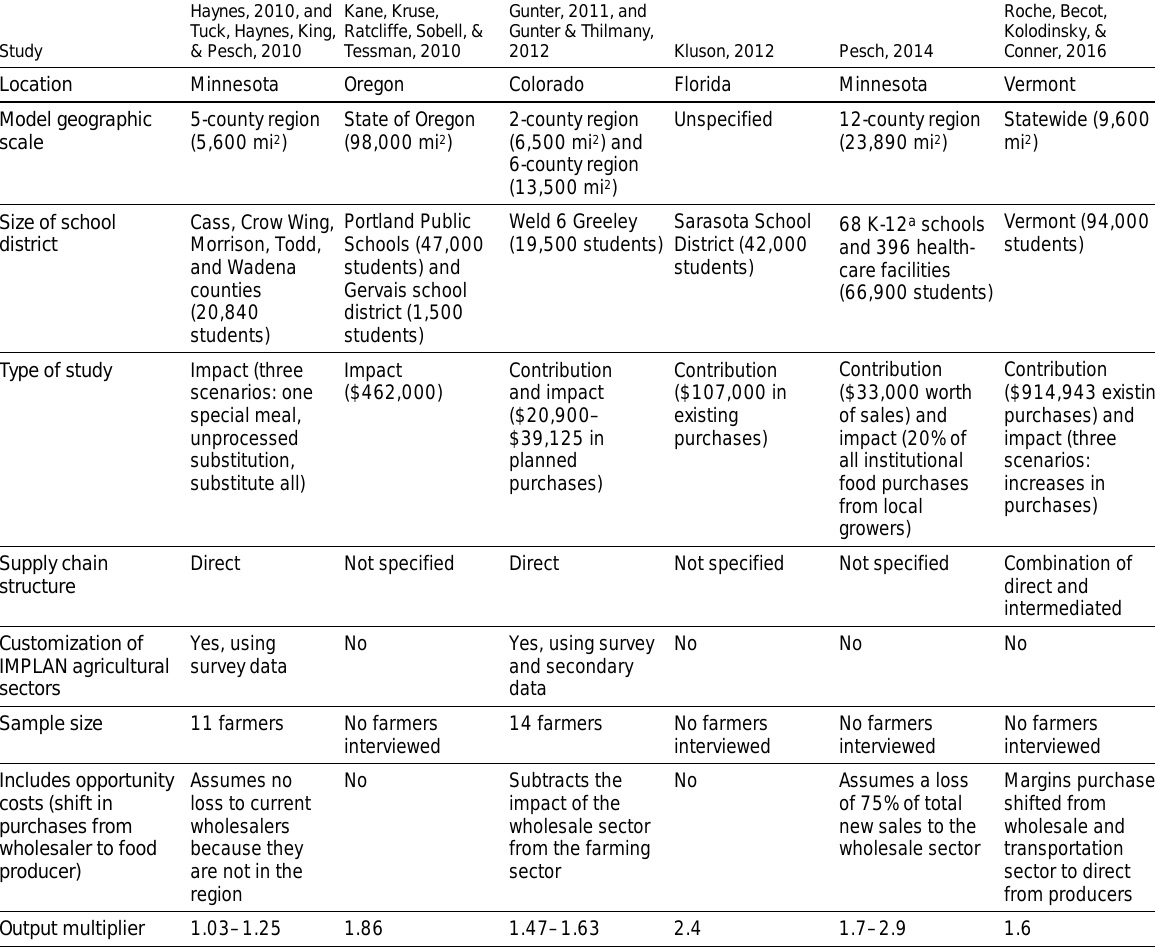
Table 2. Summary of Farm-to-School Economic Impact Assessment Studies (all currency in US$)